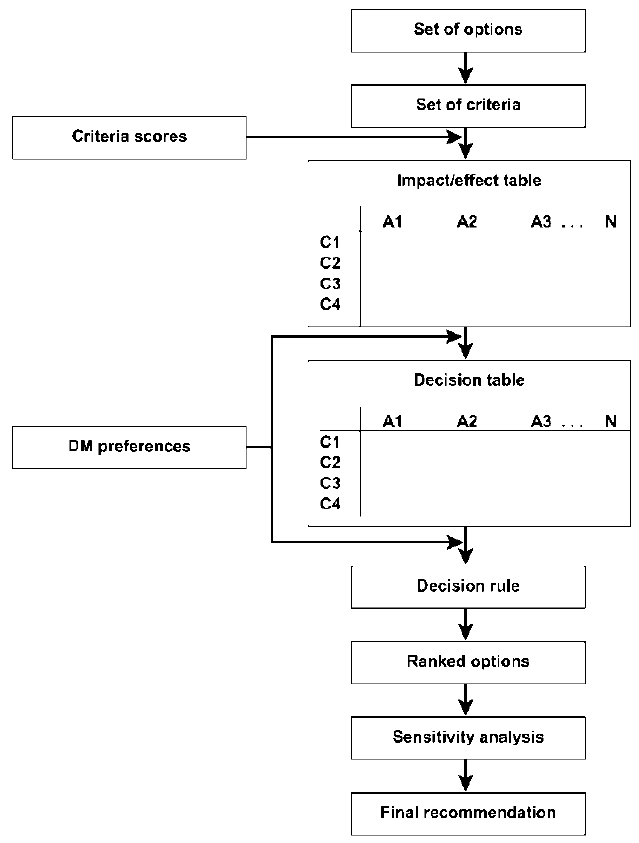
Figure 1. General model of multi-attribute decision-making method (MADM) (adapted from Sharifi et al.